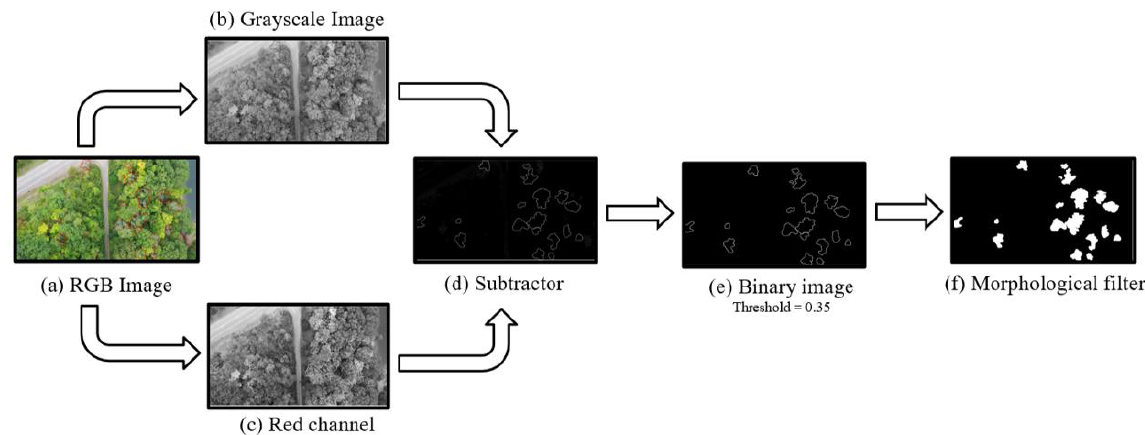
Figure 9. Workflow for binary segmentation mask generation. An RGB image ( a ) is converted into grayscale information of the RGB image ( b ) and red channel information of the RGB image ( c ). Then, a subtracted image ( d ) is used to convert to a binary image ( e ), and the final mask is generated after applying the morphological filter ( f ).